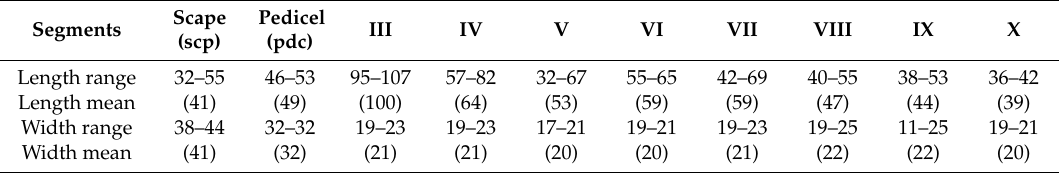
Figure 6. SEM close-up of the granular surface of the head and dorsal simple eye of male A. galliformis .